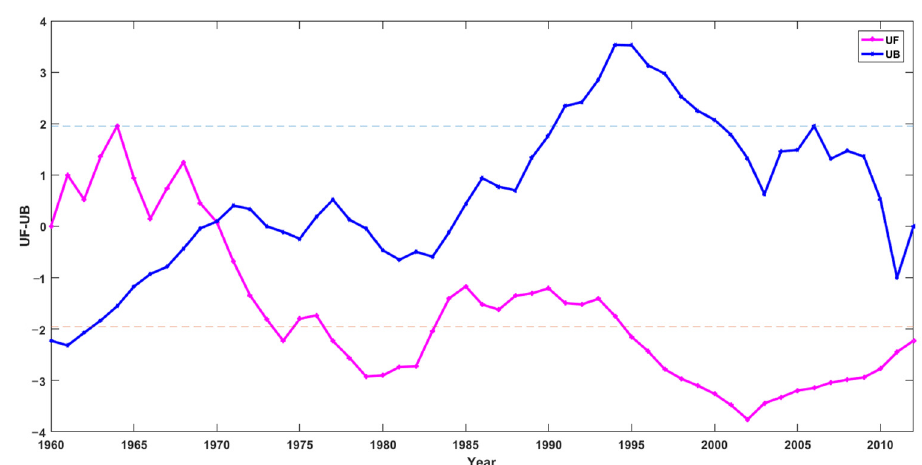
Figure 6. Mann–Kendall test statistics for the baseflow separated from historical observed daily streamflow data. The abbreviations are the same as Figure 5.